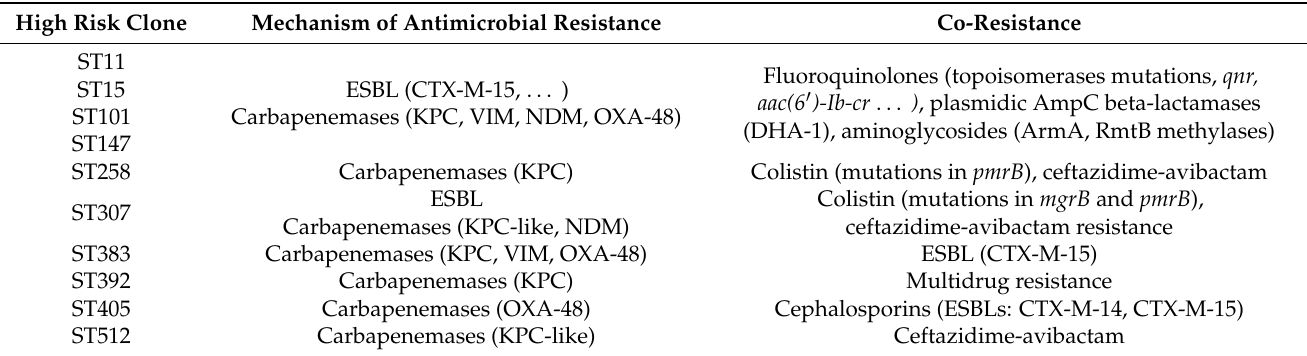
Table 1. High-risk clones in Klebsiella pneumoniae